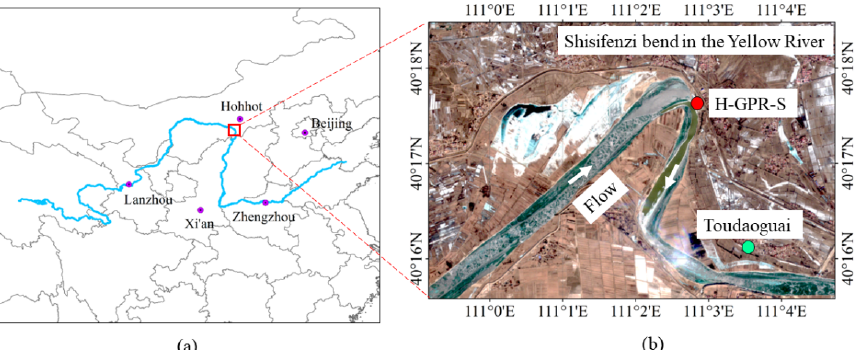
Figure 1. ( a ) The Yellow River mainstream; ( b ) Shisifenzi bend in the Yellow River and installation site of H-GPR-S (red dot) and Toudaoguai Hydrological Station (green dot). The background is the Yellow River ice image on 23 January 2021 derived from the Sentinel-2 satellite (https://scihub.copernicus.eu/dhus/, accessed on 23 January 2021).